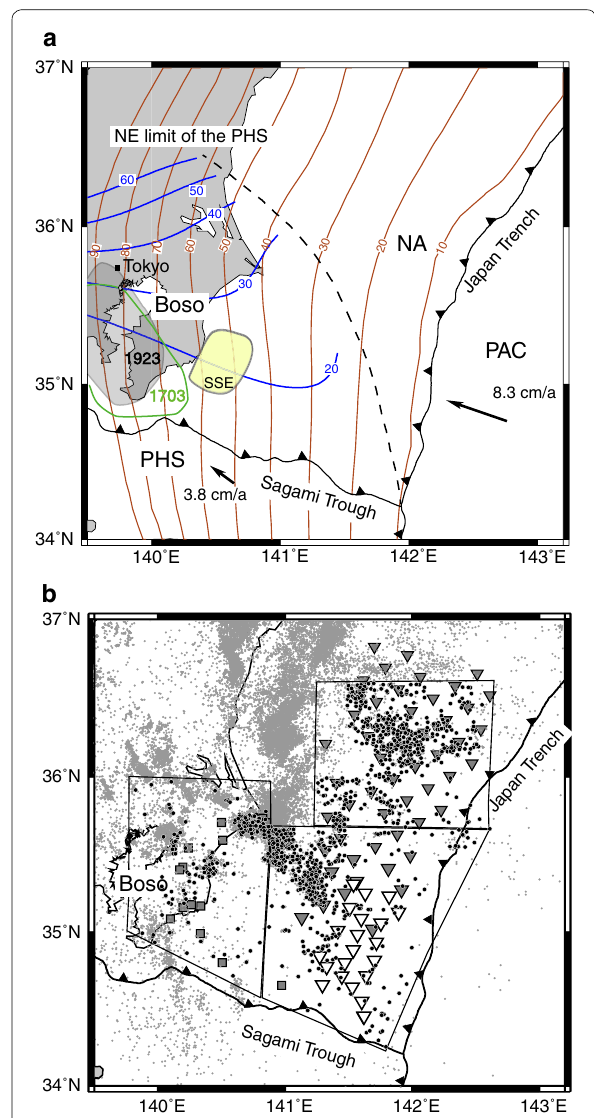
Fig. 1 Tectonic setting of the study area and locations of seismic sta- tions. a Blue and brown contours show the depths of upper bounda- ries of the PHS (Uchida et al. 2010) and the PAC (Nakajima et al. 2009), respectively. The black dashed line denotes the northeastern limit of the PHS (Uchida et al. 2009). Source areas of the 1703 Genroku Kanto and 1923 Kanto earthquakes are indicated by gray and green lines , respectively (Matsu’ura et al. 2007; Sato et al. 2016). The area of slow slip events is shown in yellow (Hirose et al. 2014). Black lines with triangles represent trench axes. Black arrows indicate the motion of PAC and PHS with respect to the NA (DeMets et al. 2010). b Locations of seismic stations. White and gray triangles indicate OBSs of JAMSTEC and ERI, respectively, while gray squares indicate stations operated by NIED. Small gray dots are earthquake epicenters determined by JMA between October 2011 and March 2013. Earthquake selection areas are delineated by black lines while black dots are epicenters determined by JMA and analyzed in this